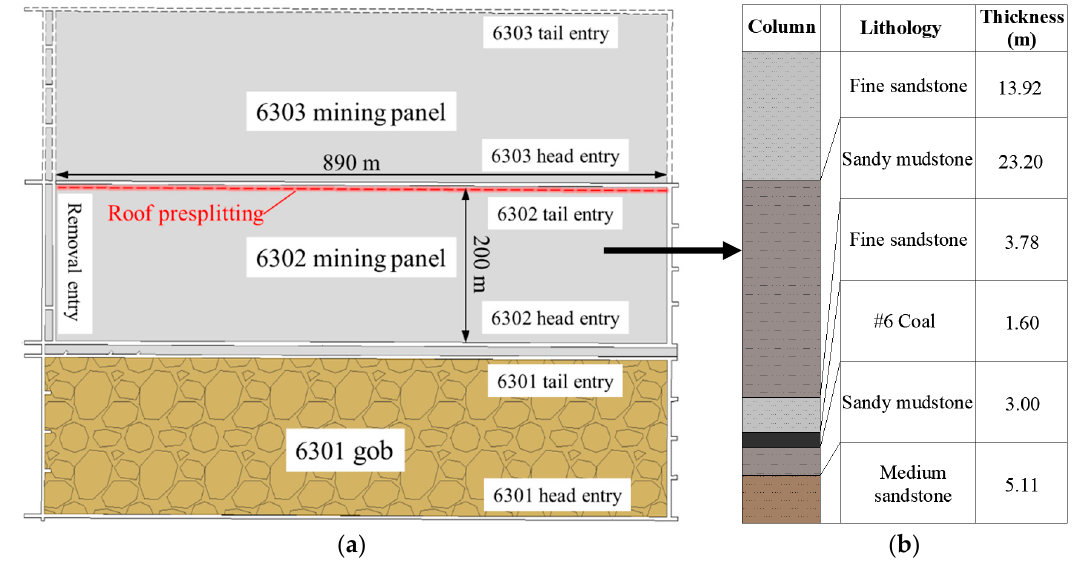
Figure 7. Site geological conditions. ( a ) Mining panel layout; ( b ) stratigraphic column of the 6302 mining panel.